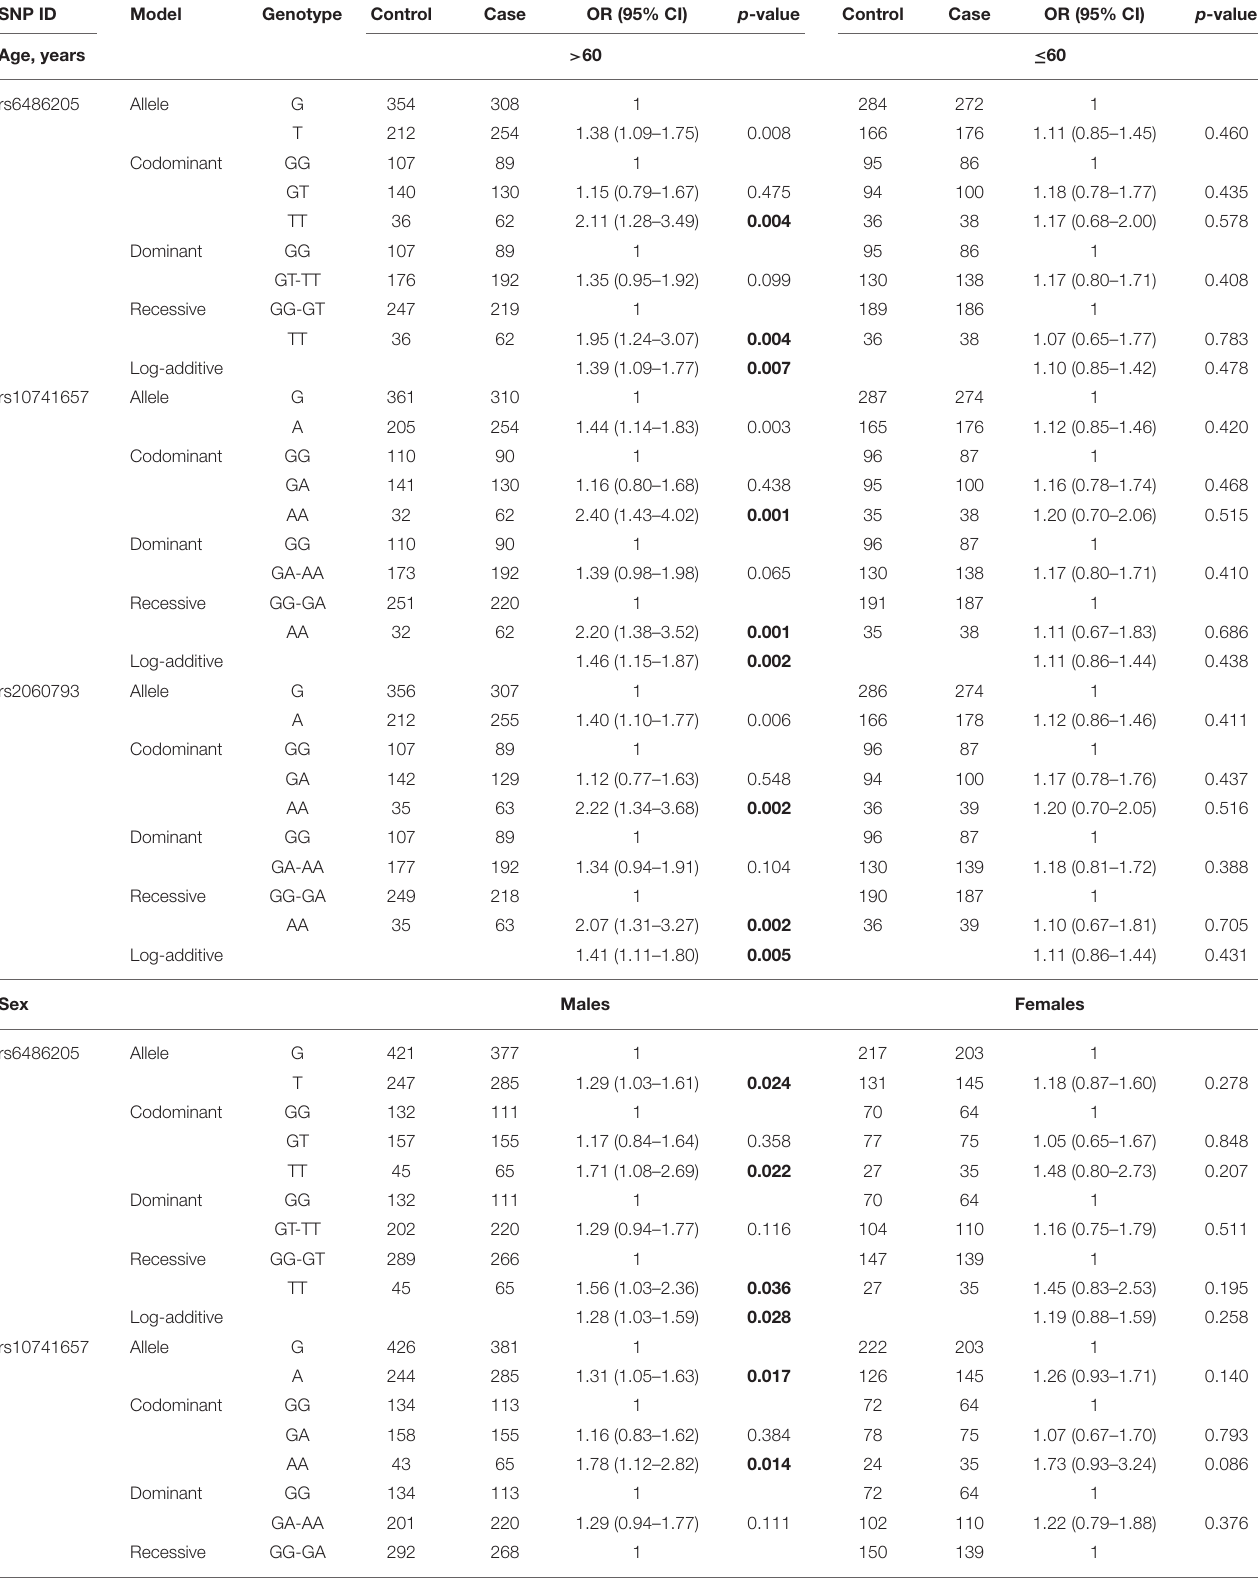
TABLE 4 | Association between CYP2R1 polymorphisms and CHD risk according to stratification by age and